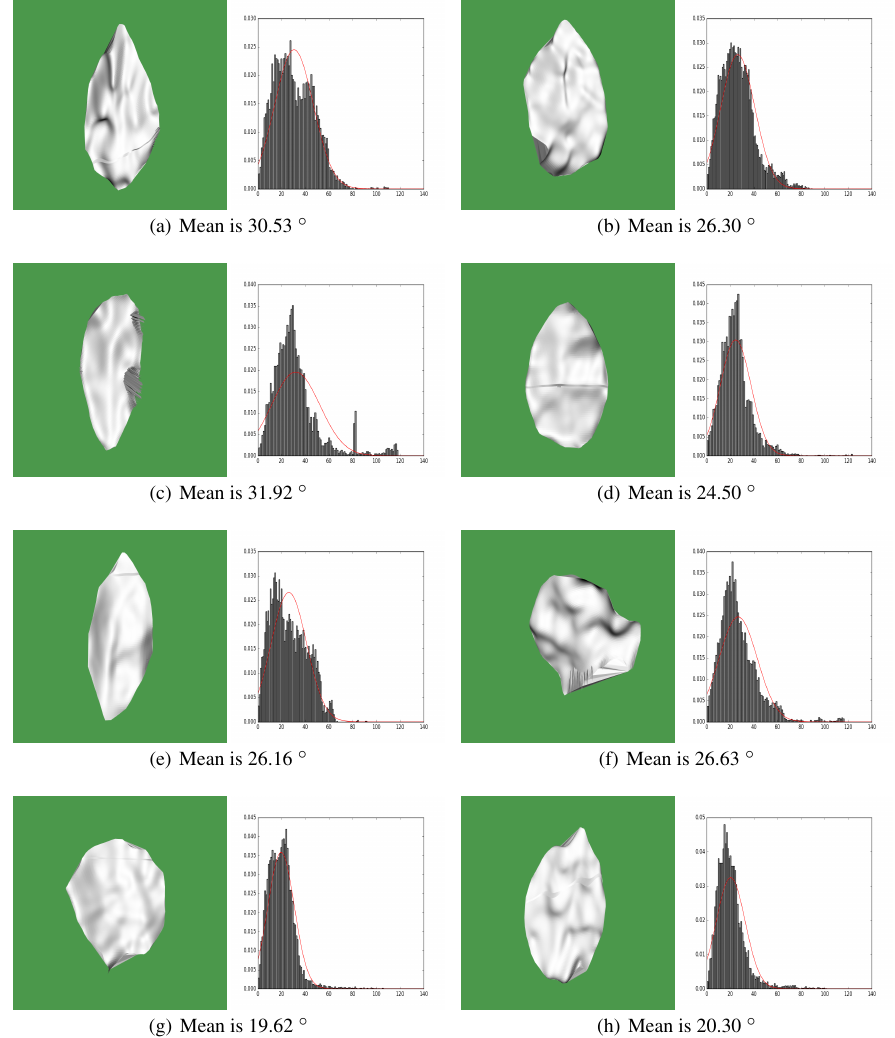
Figure 5. The included angle statistics of 8 planar